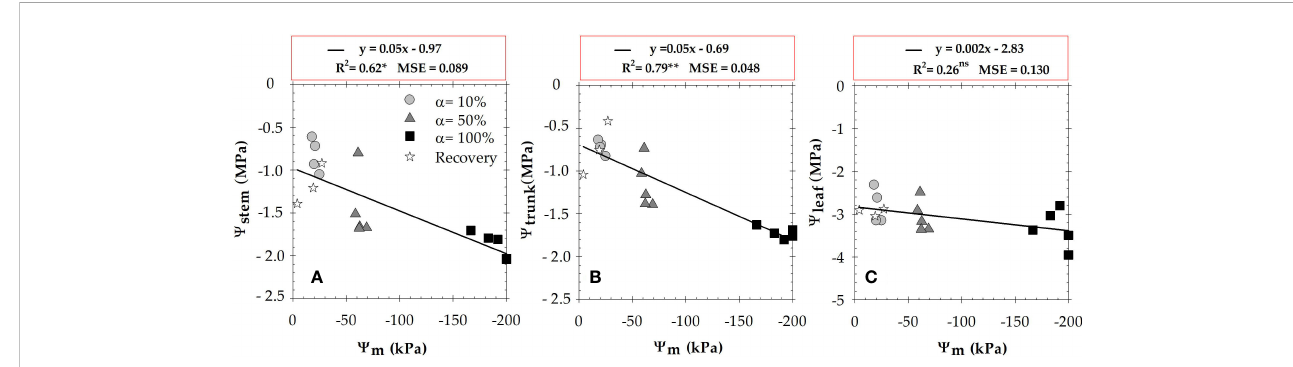
FIGURE 3 Relationship between the midday values of soil matric potential ( Y m ) (average of 0.3 and 0.6 m), and (A) stem water potential ( Y stem ); (B) trunk water potential ( Y trunk ); and (C) leaf water potential ( Y leaf ), during the experimental period. The different symbols correspond to the four irrigation criteria. Each point is the mean of four leaves and two matrix sensors. R 2 is the coef fi cient of determination. *: p ≤ 0.05 **: p ≤ 0.01, ns: not signi fi cant. MSE: mean squared